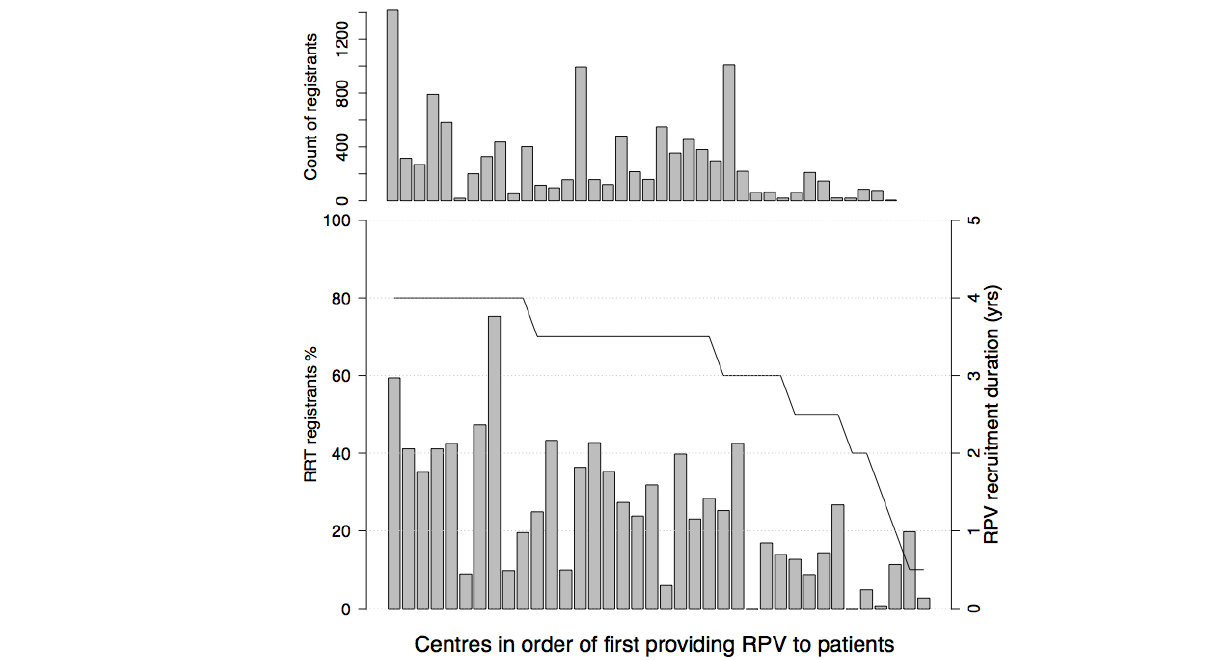
Figure 3. RPV registration by center. Number of registrants (top chart) and proportion (%) of available RRT patients registered for RPV is shown by renal center, ordered by the start date of patient enrollment. The duration of active RPV enrollment is superimposed on the bottom chart; duration ranged from 0.5-4